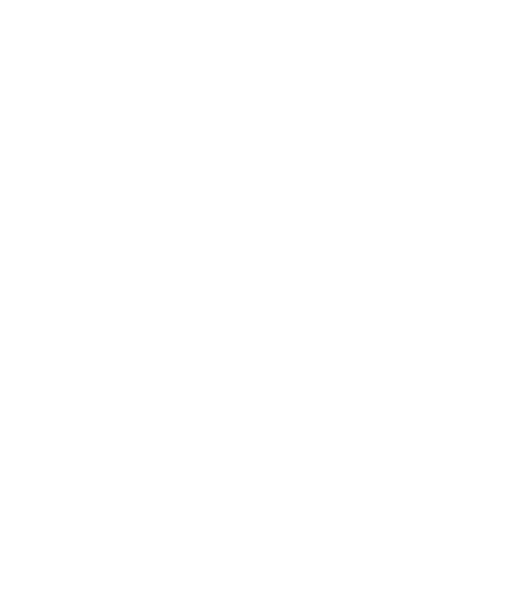
Table 2. Results of correlation coefficients between global scores of Hammersmith Infant Neurological Examination and complexity indices for joint angles and joint angular velocities (N = 65). * p <